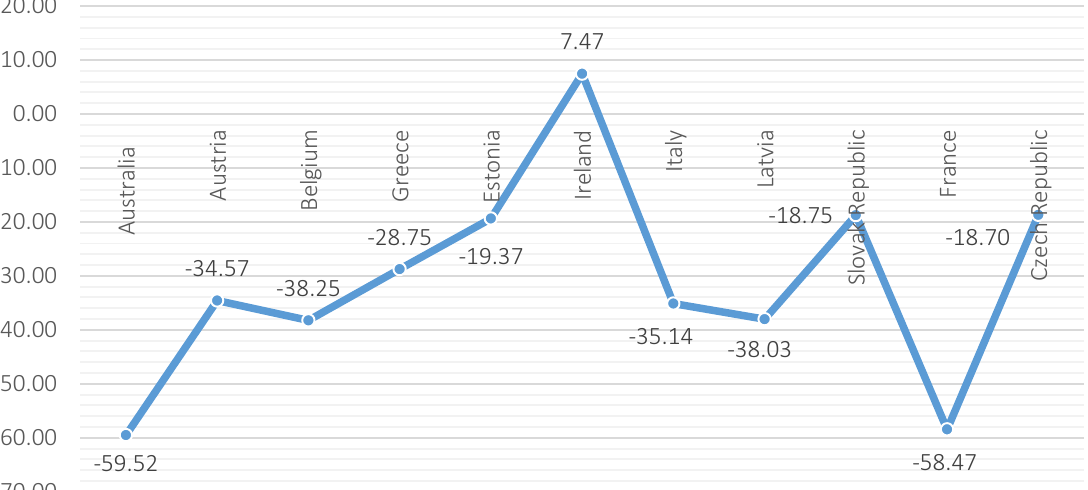
Figure 3. The rate of growth (decline) of the IR level in 2020 compared to 2010 by individual countries,